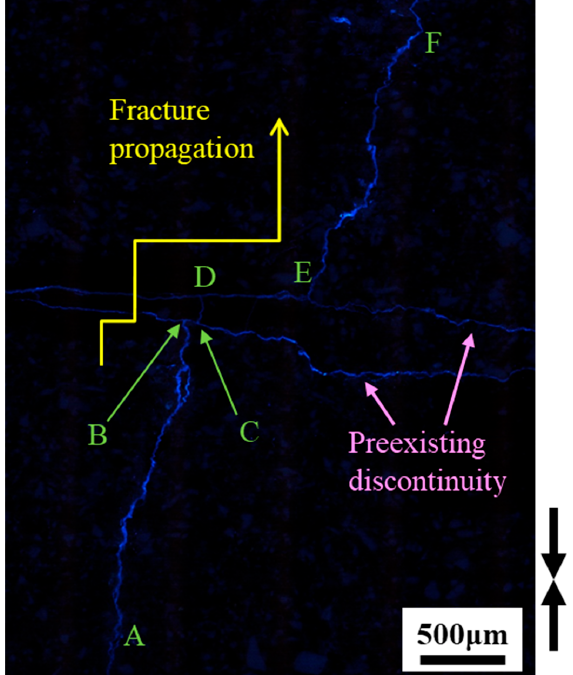
Figure 7. The influence of preexisting discontinuities on the propagation of an induced fracture (Cretaceous Kushiro shale). The pair of black arrows next to the figure represents the loading direction. The induced fracture shifted its pathway along the preexisting discontinuities for short segments (B–C and D–E) and passed through the preexisting discontinuities. The fluid-impregnated portions were not only the short segments (B–C and D–E) but also the extended portions along preexisting discontinuities surrounding the short segments.